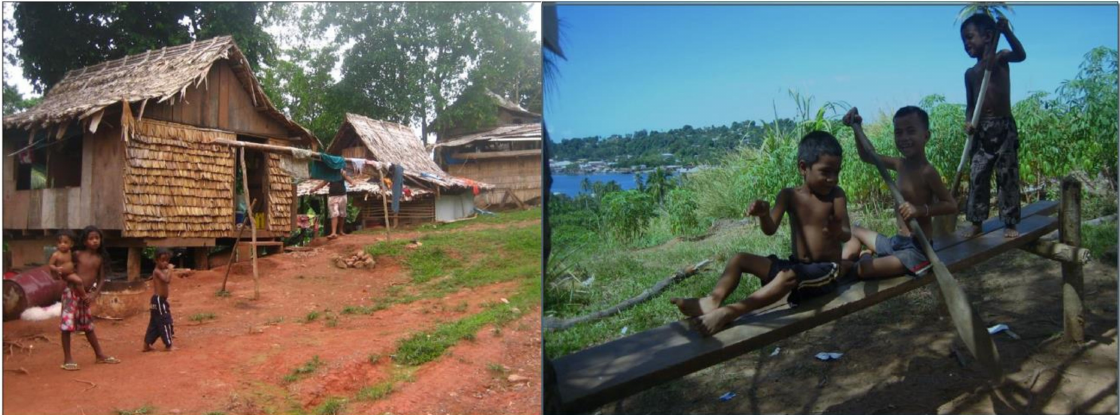
Figure 11. Relocation of some coastal villages to higher ground resulted in a different way of life and village ‘equilibrium’. Land security is key to longer-term relocation decisions. This research demonstrated that the Gilbertese Community experienced higher barriers to post-disaster adaptation because of a lack of land security for their communities. Gilbertese Communities, as ‘settlers’ and ‘migrants’ on Ghizo, did not share the historical land ownership and tenancy rights of longer-term Indigenous Melanesian